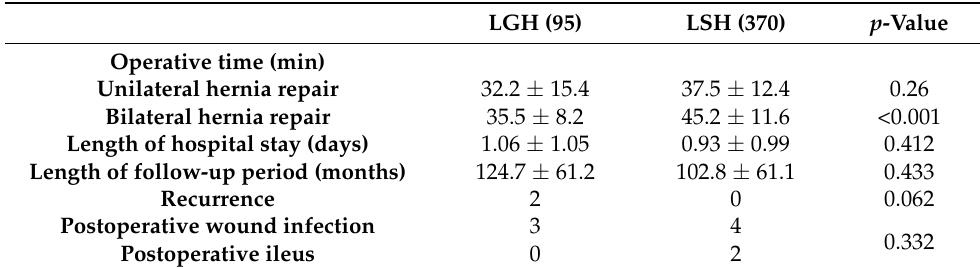
Table 2. Surgical